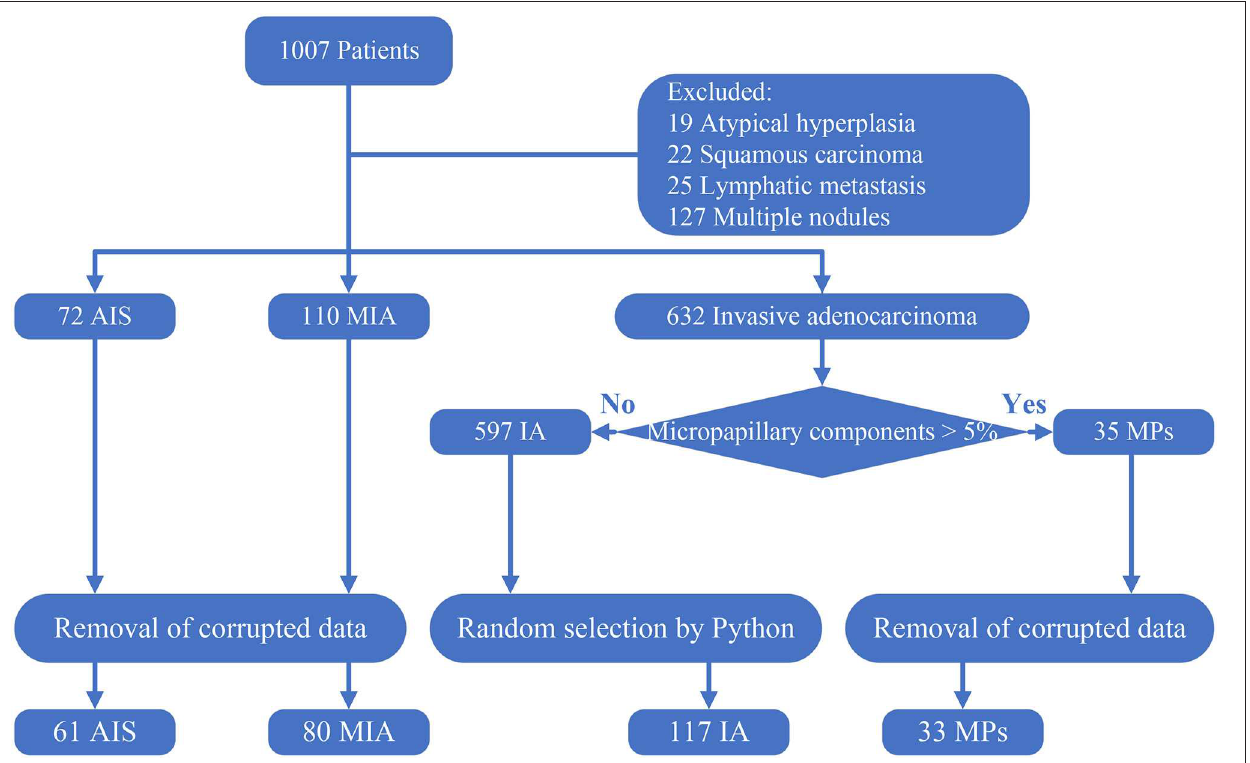
FIGURE 1 | Creation of the dataset. Corrupted data: data that cannot open and data that has a poor resolution. The 117 IA was randomly selected using a Python script from the 597 IA with no micropapillary component.